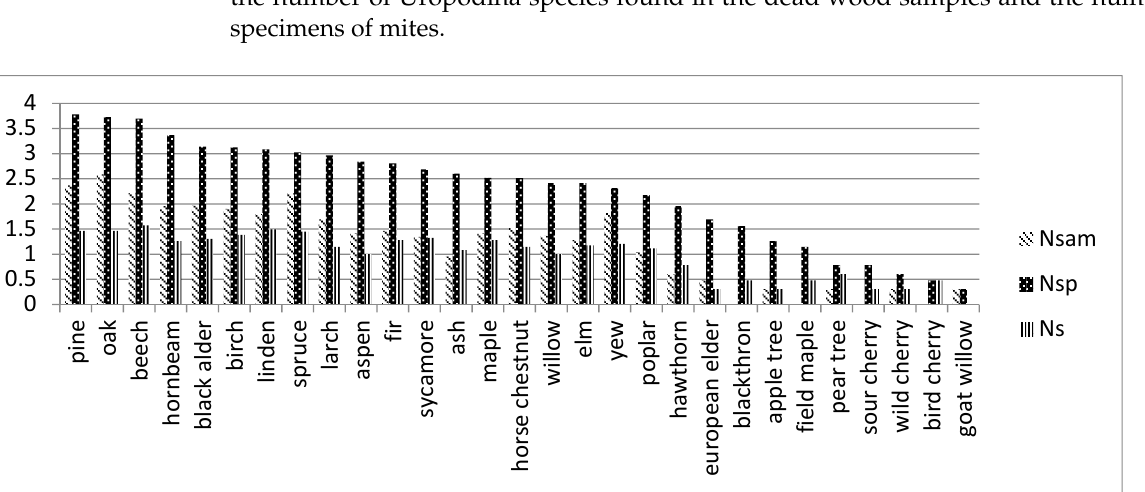
Figure 2. Number of samples (Nsam), number of specimens (Nsp) and number of Uropodina species (Ns) (logarithmic scale) for examined tree species (according to the number of